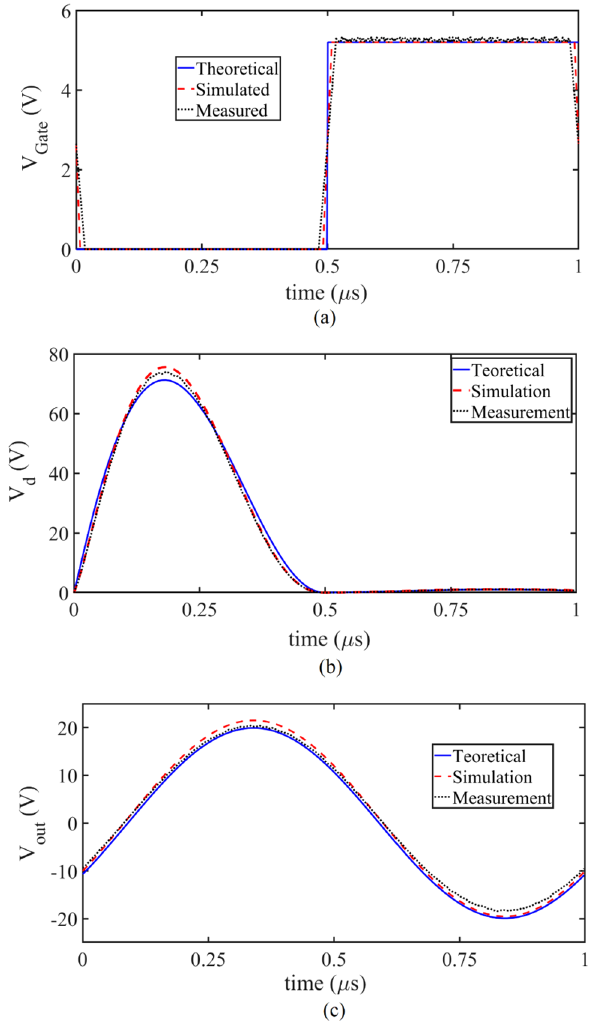
Figure 23. ( a ) The output driver voltage is applied to the transistor gate. ( b ) V d and ( c ) the output voltage for the simulation, theoretical, and fabrication at 25